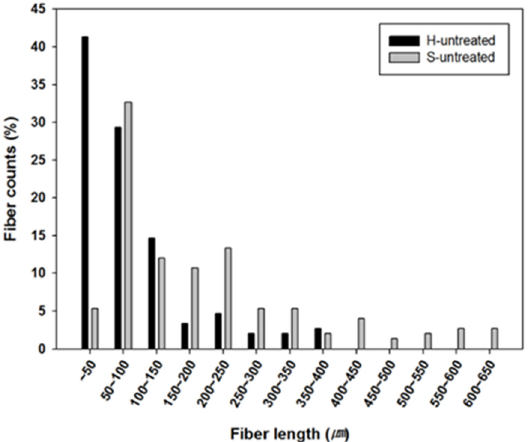
Figure 7. A histogram showing the henequen fiber length distribution measured with ‘H-untreated’ and ‘S-untreated’ henequen fiber/PA6